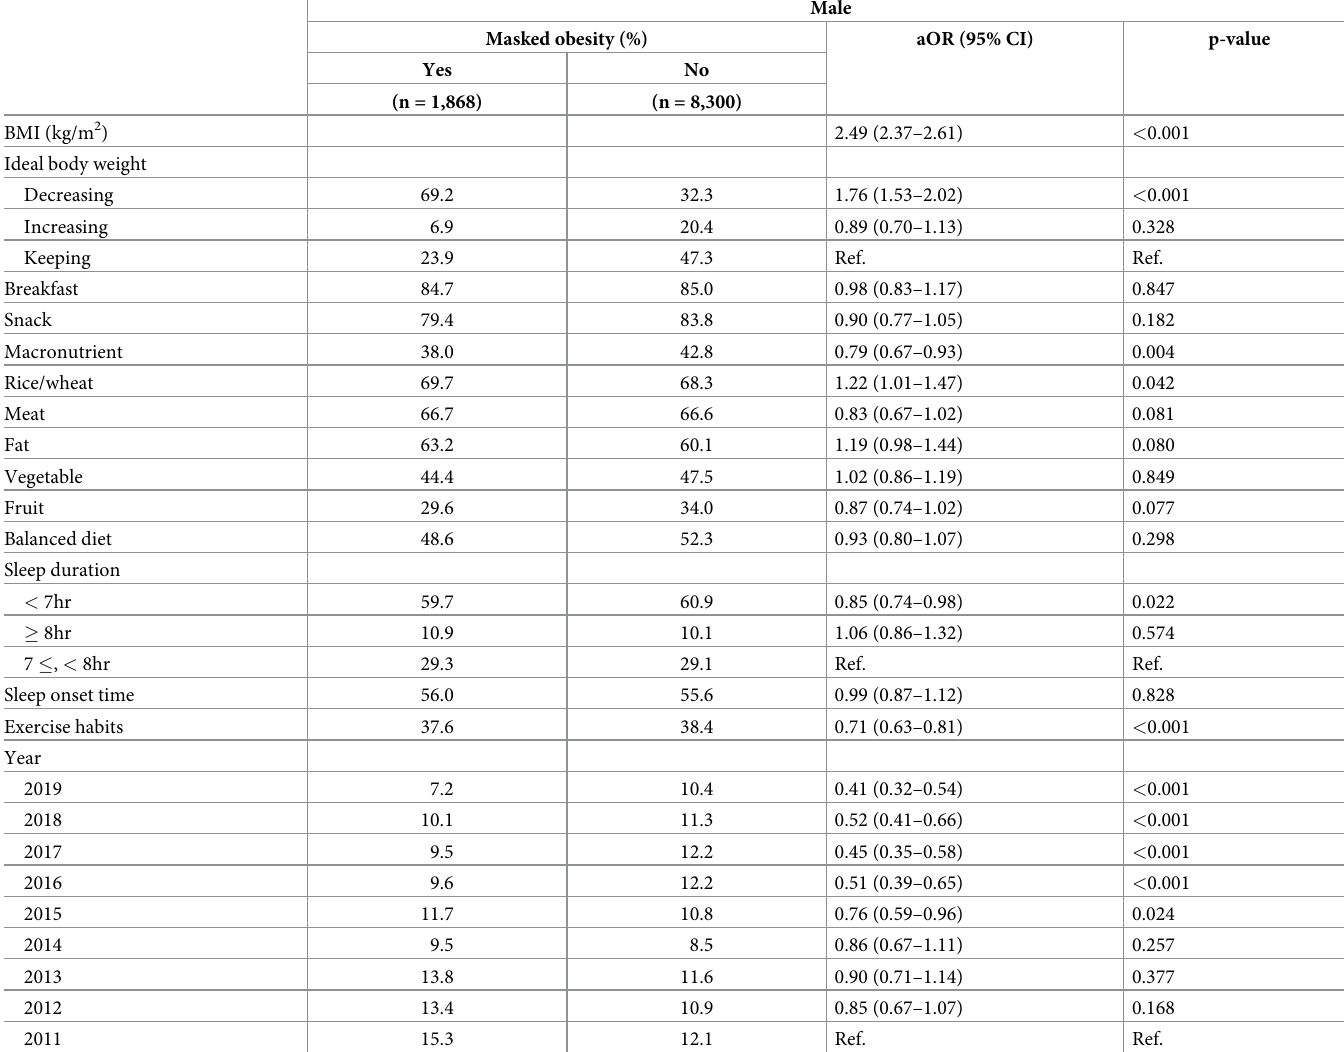
Table 3. Relationship between masked obesity and weight control orientation or lifestyle habits in male students.